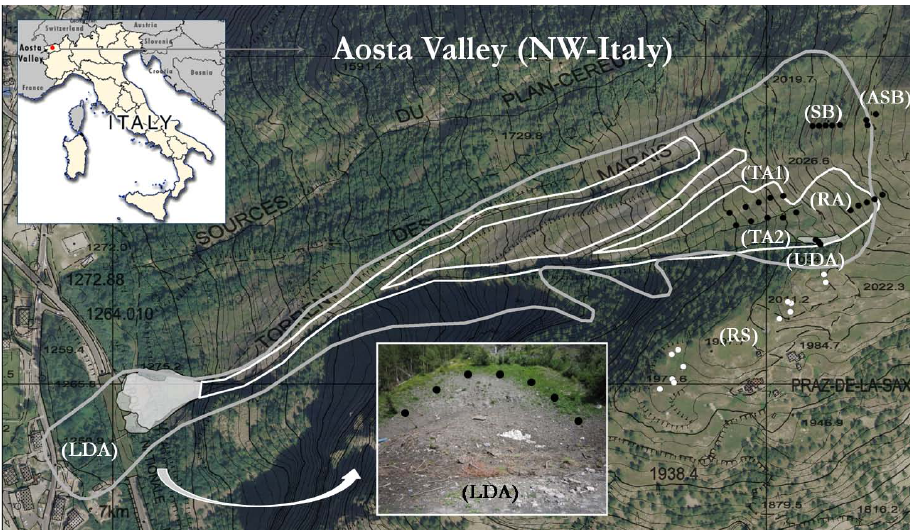
Fig. 1. Avalanche site called “Torrent de Marais – Mont De La Saxe” – Gray line: perimeter of the maximum event recorded in the Avalanches Cadastre of the Valle d’Aosta Region; white line: release and track perimeters of the events recorded in the seasons 2009 and 2010; gray areas (light and dark): avalanche deposits of the same events (source: RAVDA-Snow and Avalanche Office); white circles: sample points for Reference Site (RS); black circles: sample points for soil redistribution rates for Release Area (RA), Track Area (TA), Snow Bridge area (SB), Above Snow Bridge area (ASB), Upper Deposition Area (UDA), Lower Deposition Area